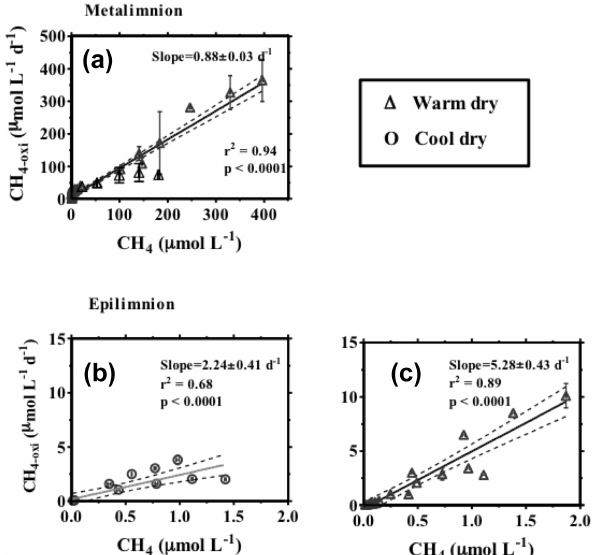
Figure 5. Linear relationships between methane (CH 4 ) concentra- tions and aerobic methane oxidation in the (a) metalimnion, (b) the epilimnion in the cool dry season, and (c) the epilimnion in the warm dry season at the Nam Theun 2